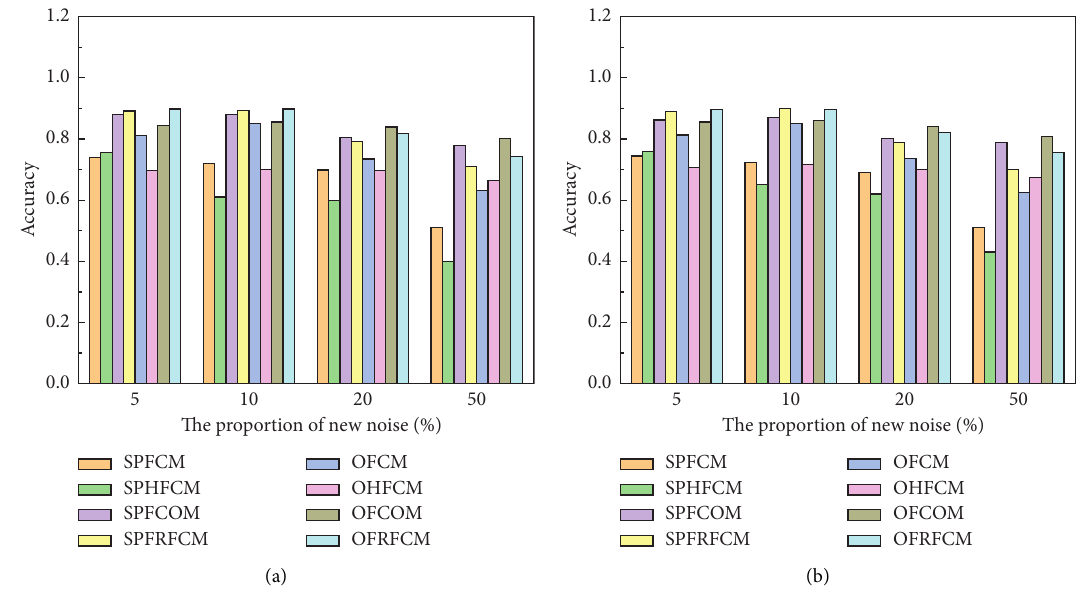
Figure 6: Robustness comparison on the PB dataset. (a) Accuracy; (b) F-Measure.